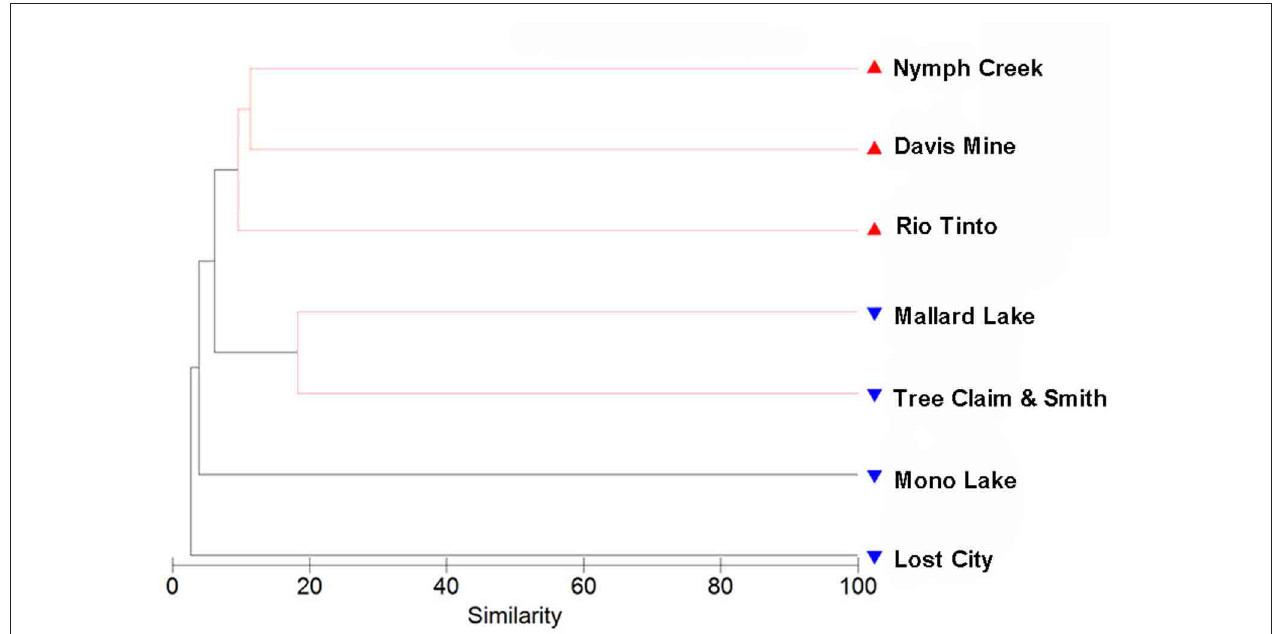
FIGURE 3 | Hierarchical clustering analysis using a resemblance matrix composed of Jaccard derived similarities between samples. Acidic samples are indicated with red symbols while alkaline samples